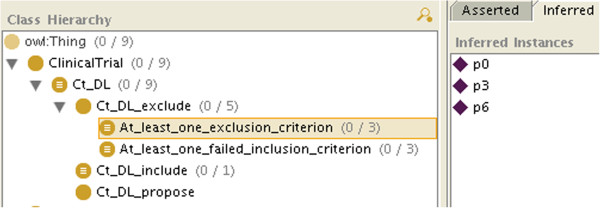
The class modeling clinical trial exclusion because at least one of the exclusion criteria has been met after classification (here patientsp0,p3 andp6 match the definition).